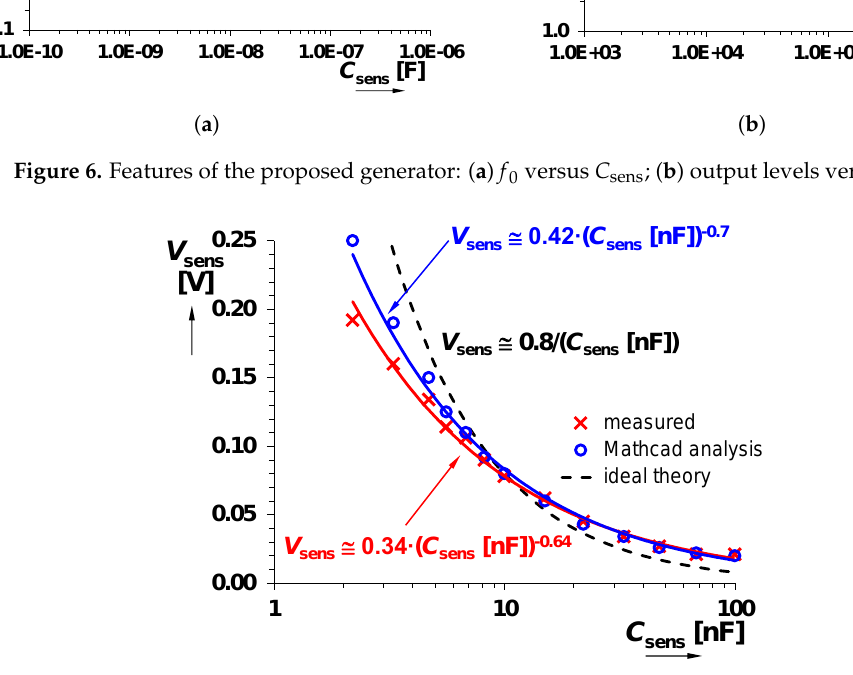
Figure 7. Comparison of the V sens versus C sens curves (theory, Mathcad simulations,